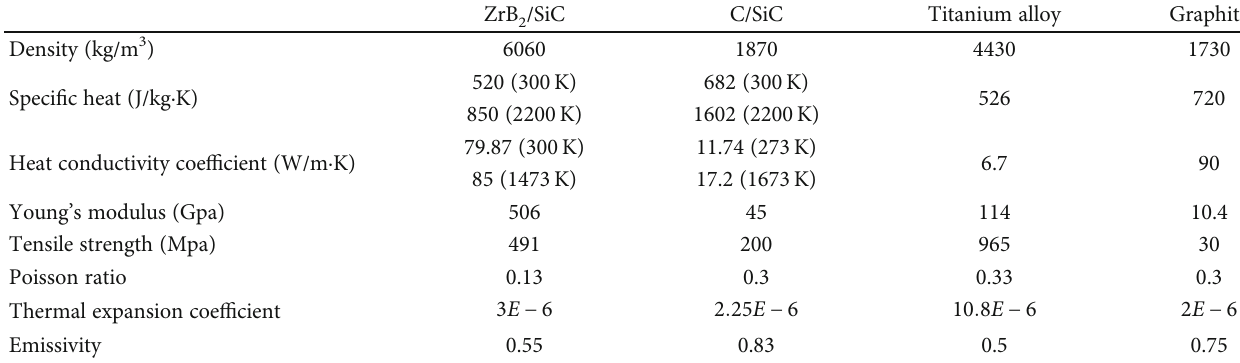
Table 3: Material properties of the nose cap.